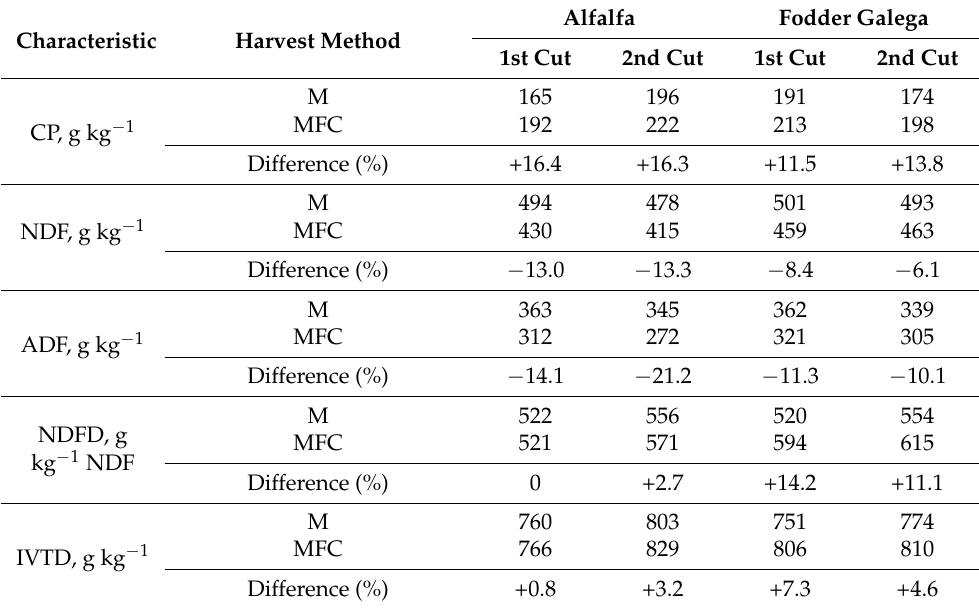
Table 5. Comparison of nutritive value parameters of alfalfa and galega forage depending on the harvest and harvest method (means over two years). Alfalfa data are adapted from Andrzejewska et al. [27]. Alfalfa Fodder Galega Characteristic Harvest Method 1st Cut 2nd